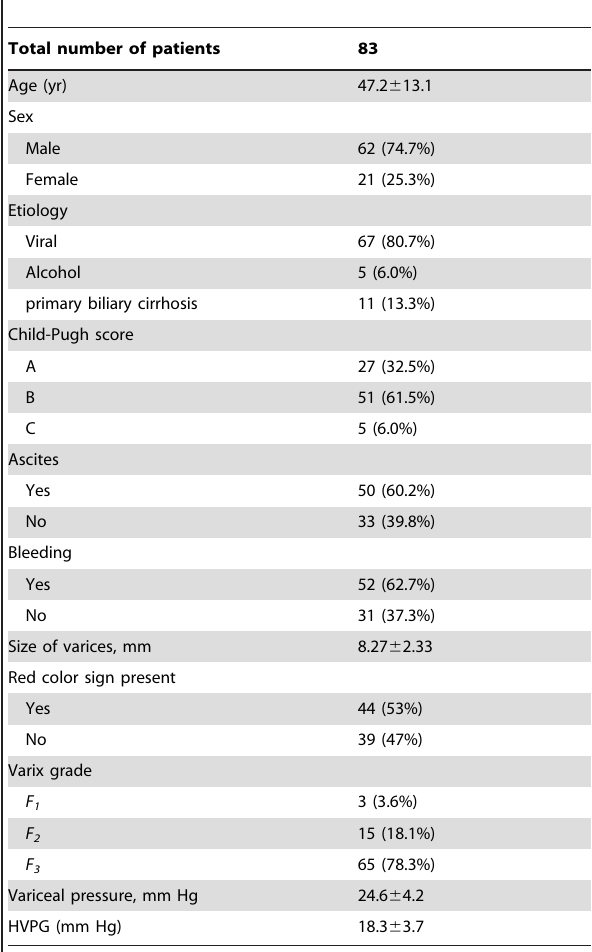
Table 1. Demographic and clinic profile of the study